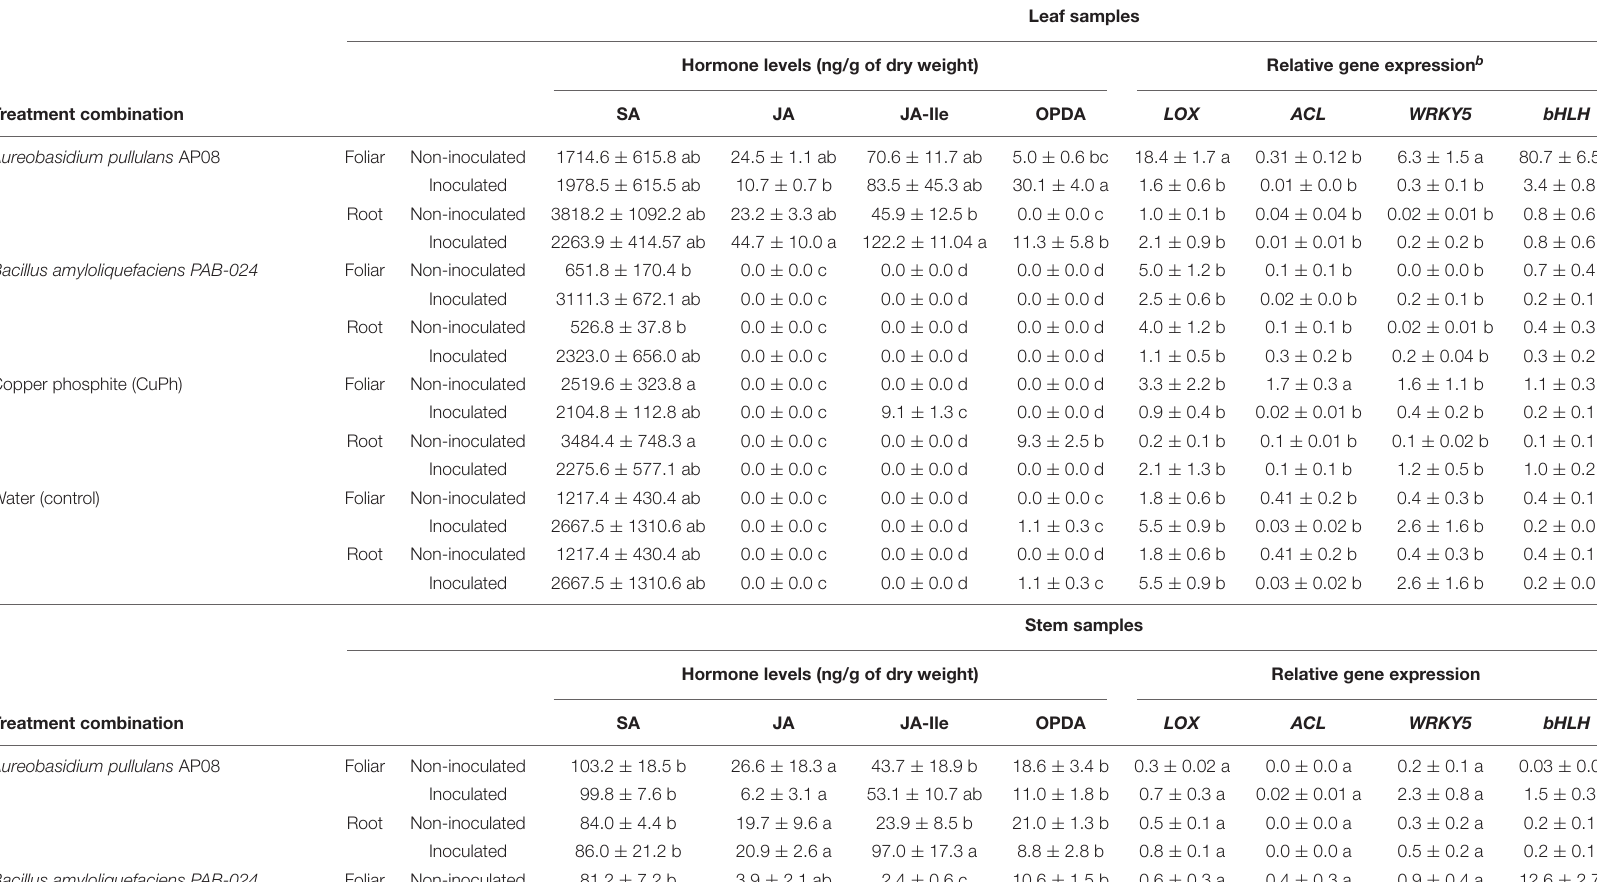
TABLE 3 | Hormone levels (ng per g of dry weight) related to salicylic acid (SA), jasmonic acid (JA), precursor of JA (OPDA), and JA-Isoleucine (JA-Ile) and relative expression of genes involved in the synthesis of acetone cyanohydrin lyase ( ACL ) and lipoxygenase ( LOX ), and the transcription factors involved in SA signal transduction ( WRKY5 ) and factors responsive to JA (basic helix-loop-helix; bHLH ) in leaf, stem and root samples from olive plants of